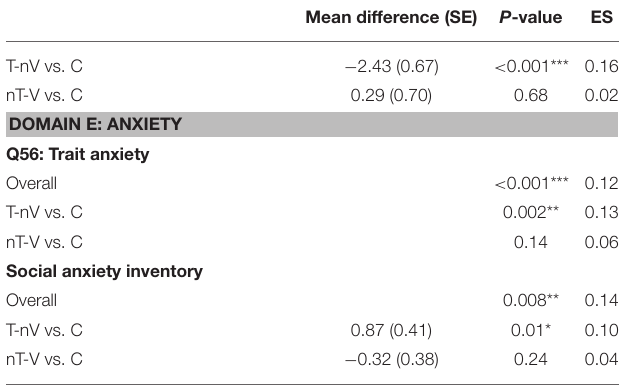
Multivariable logistic regression based on group T-nV and group C ( Table 4, Supplementary Table 2 ) suggested that higher PC1 scores, which represented a lower perceived risk of SARS- CoV-2 infection in dental hospitals, was associated with reduced likelihood of unnecessary dental avoidance (odds ratio [95% CI]: 0.62 [0.53, 0.72]; p < 0.001). Participants with higher scores along PC3, which was indicative of the less perceived